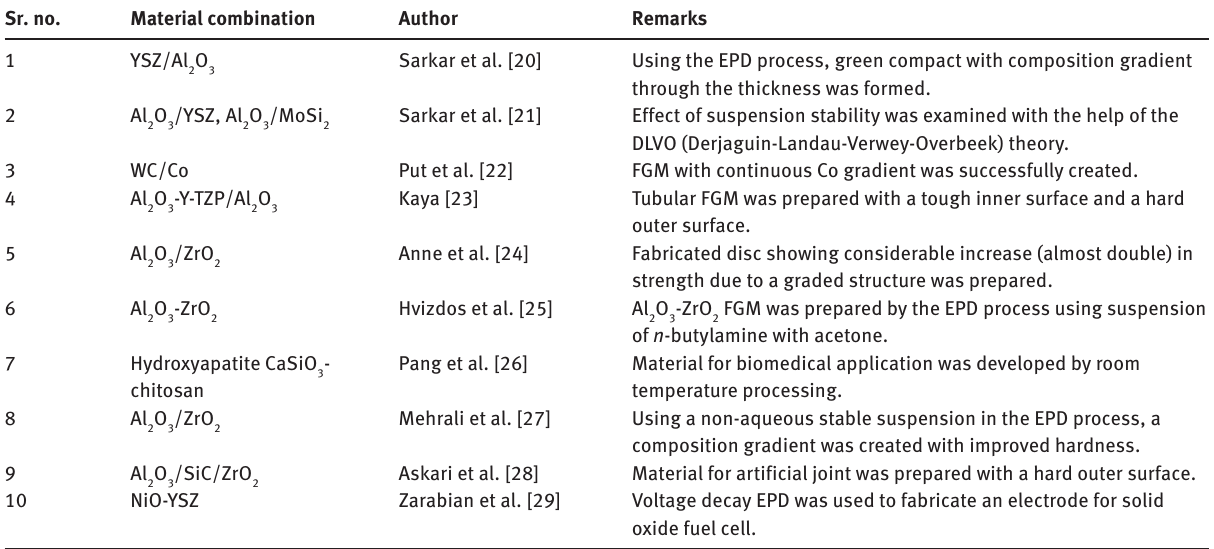
Table 2: List of different authors who used EPD for fabrication of FGM. Sr. no. Material